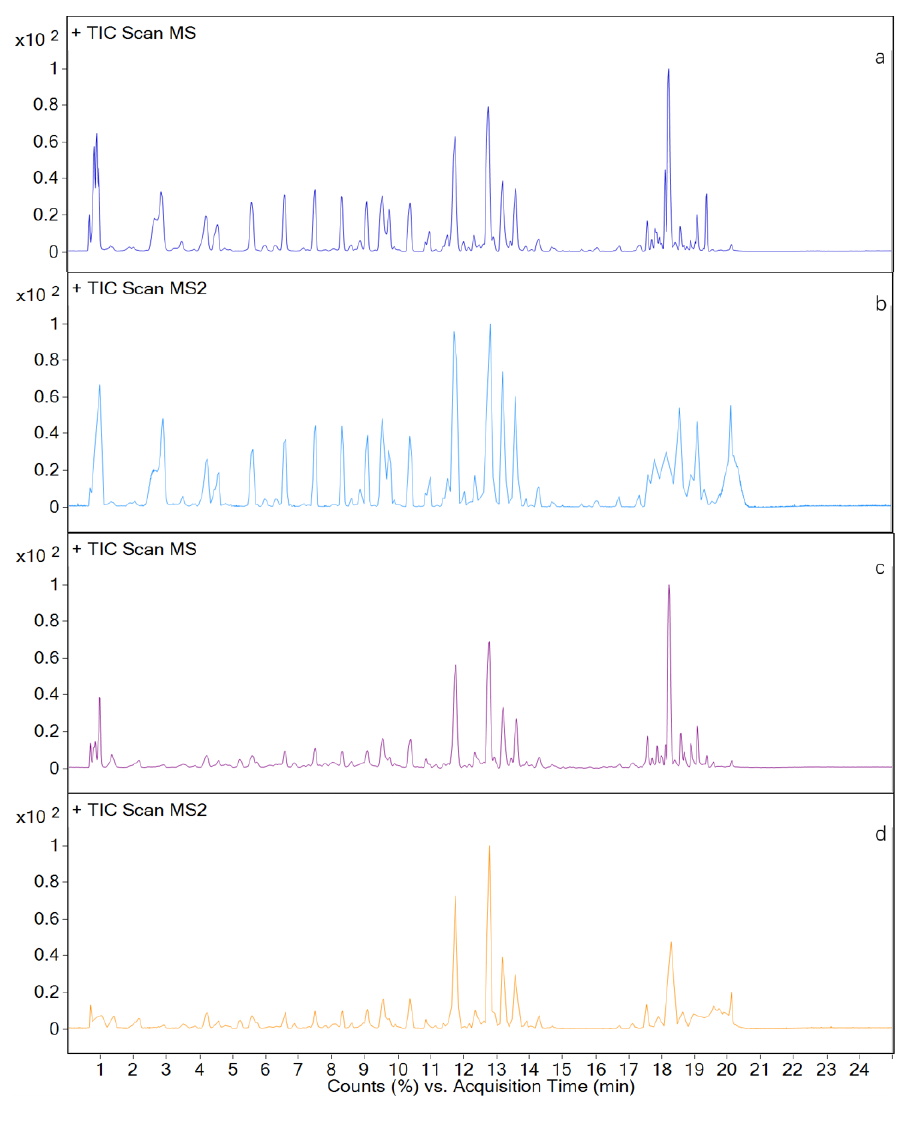
Figure A5. Total ion chromatograms of feces. ( a , b ) Blank feces; ( c , d ) Sample feces.